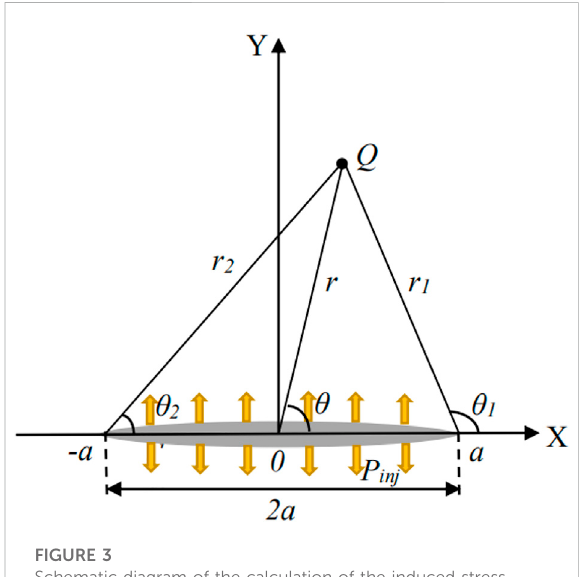
FIGURE 3 Schematic diagram of the calculation of the induced stress fi eld around the fracture.